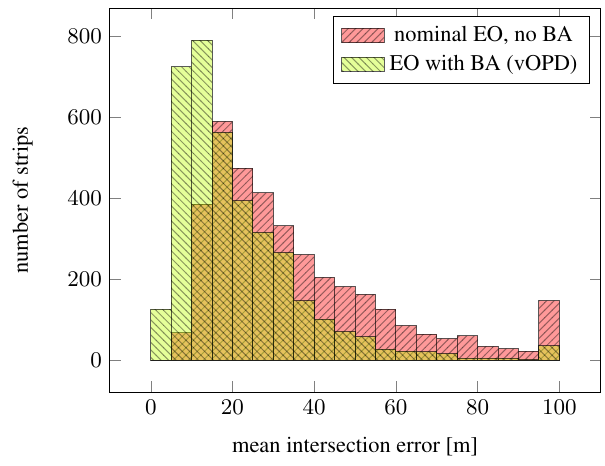
Figure 7: Histogram of 3,686 HRSC image strips with respect to mean intersection error